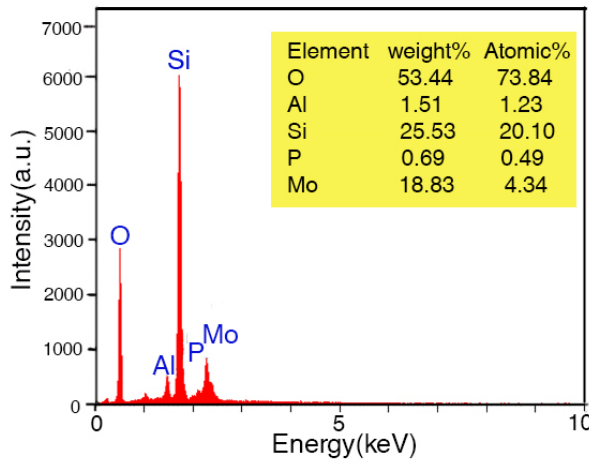
Fig. 2. EDS of Figure 2 . EDS of HPA-ZSM-5